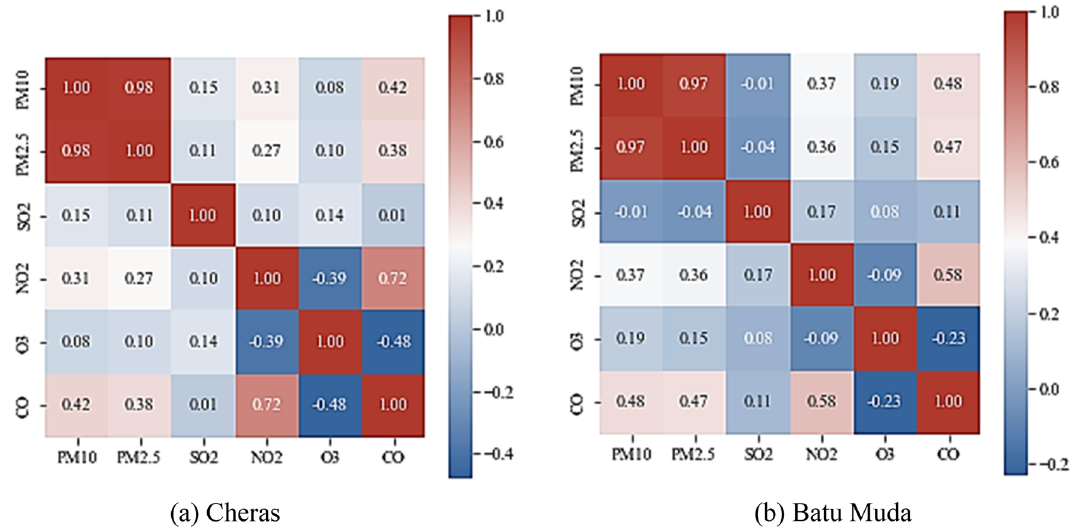
Figure 3. Pearson’s correlation of PM2.5 concentration and other features for ( a ) Cheras and ( b ) Batu Muda where n is the number of observations in the dataset. X t and y t are historical PM2.5 concentrations and other air pollutants series, respectively. x t and y t are the mean value of historical PM2.5 concentration and other air pollutants series, respectively. The heatmap in Fig. 3 illustrates the correlation between PM2.5 and other air pollutants at both air quality also affect the changes in PM2.5 concentration. Meanwhile, the correlation value of SO 2 is 0.04, which is closest to zero, indicating that the variable has the weakest correlation to PM2.5 concentration. Therefore, the input concentration at Cheras station.